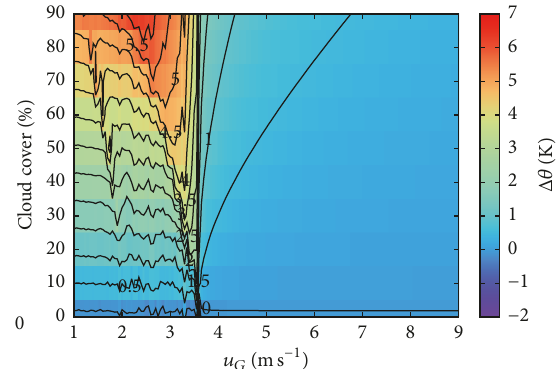
Figure 6: Temperature differences considering the variation on the cloud cover from 0 to 90%. The CO 2 concentration is considered being 73% of the actual value.